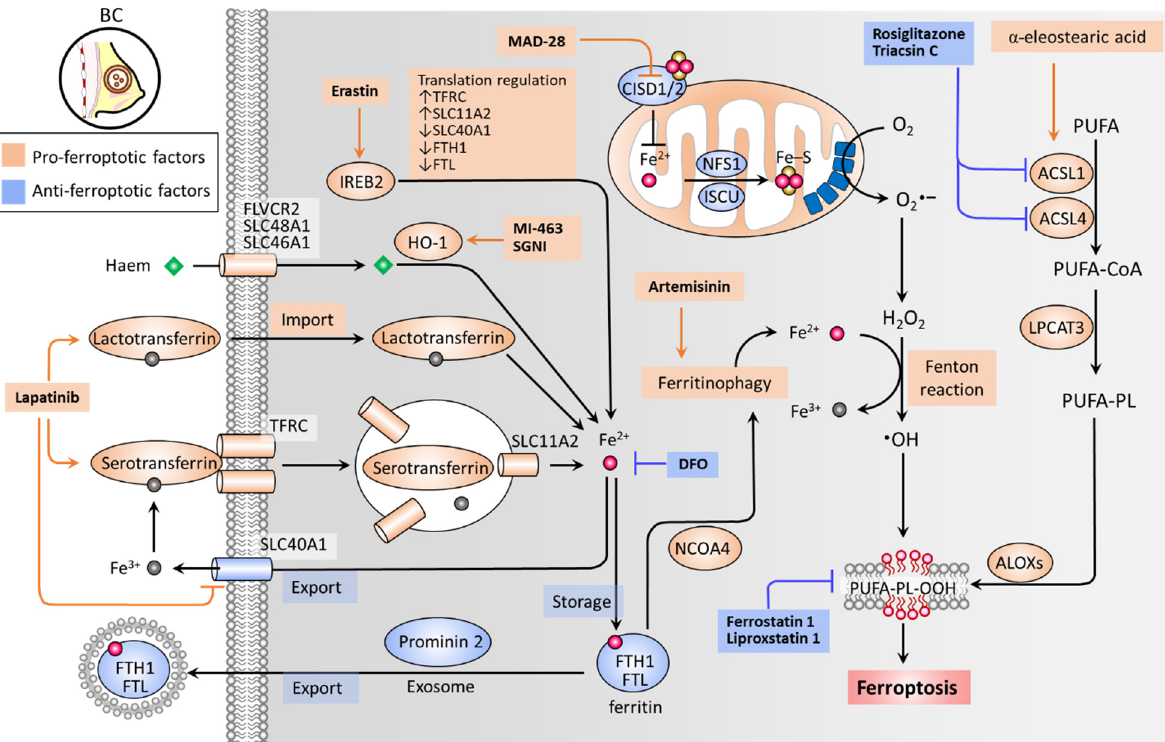
Figure 1. Iron metabolism and lipid peroxides in ferroptosis. Ferroptosis is primarily triggered by iron accumulation- mediated lipid peroxidation, which is determined by key factors contributing to the import, export, and metabolism of iron and the formation of PUFA-PL-OOH. Serotransferrin-TFRC complexes load iron and facilitate its import through endosome internalization, by which iron can be released via SLC11A2. IREB2 transcriptional activity, heme/HO-1, and lactotransferrin provide additional routes of intracellular iron import. DFO acts as a scavenger of intracellular iron. FTH1 and FTL together form an iron storage protein complex (ferritin), preventing Fe 2+ from being oxidized to Fe 3+ by the Fenton reaction. Prominin-2 acts to form FTH1/FTL/iron complex-containing exosomes, which are then exported to the extracellular space. NCOA4 plays a role in inducing autophagic degradation of FTH1/FTL (ferritinophagy), leading to an increase in intracellular iron. ACSLs and LPCAT3 facilitate the formation of PUFA-PLs, which are susceptible